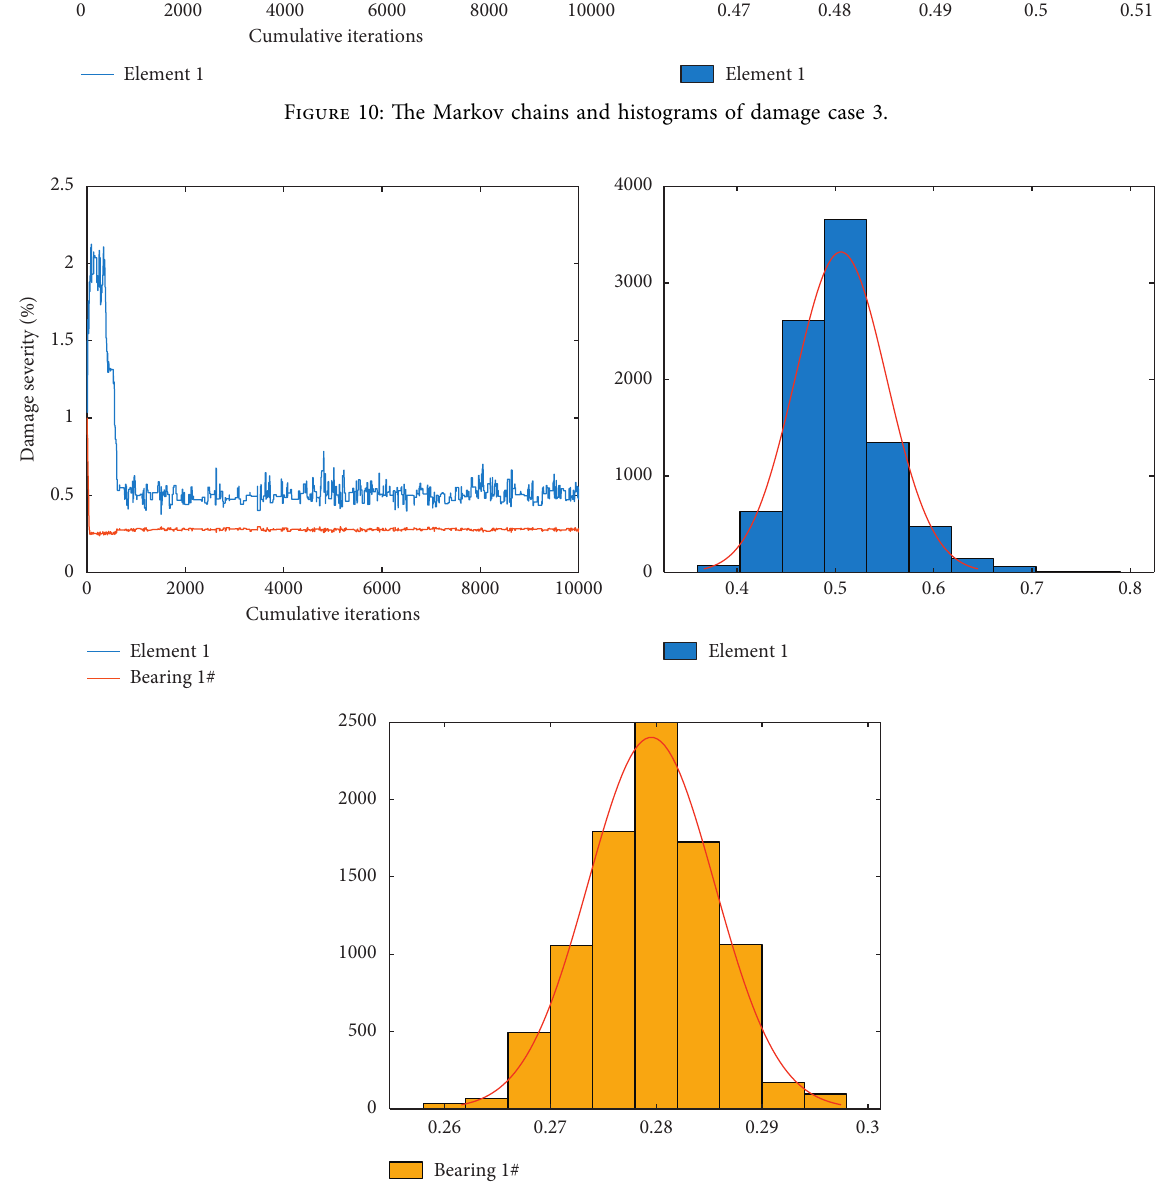
Figure 11: The Markov chains and histograms of damage case